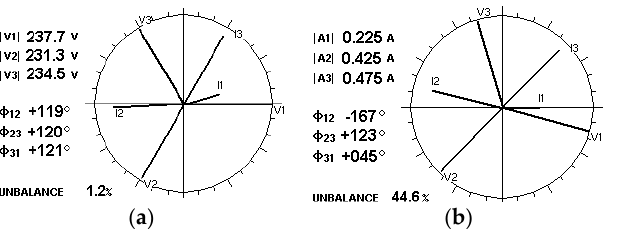
Figure 7. Fresnel diagrams for fundamental voltages and currents for 230 V (set 1). ( a ) is voltages. ( b ) is currents.